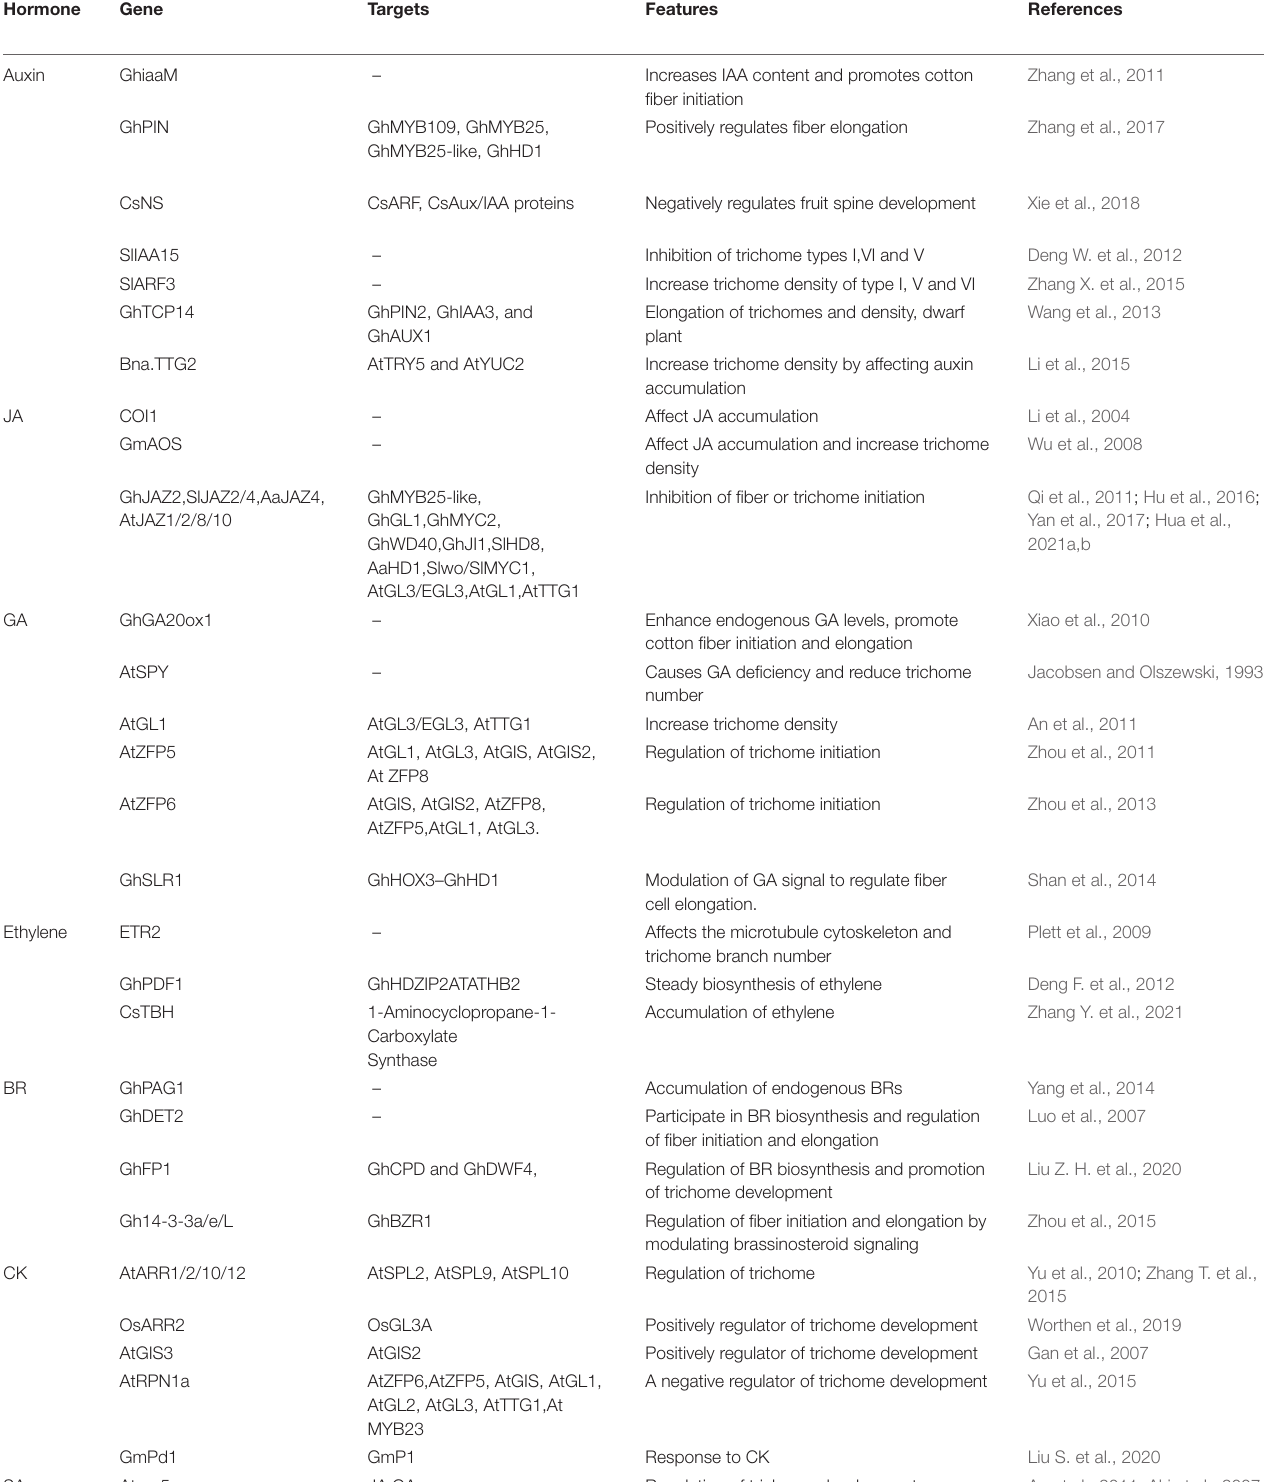
TABLE 1 | Summary of phytohormones-mediated regulators modulation of trichome